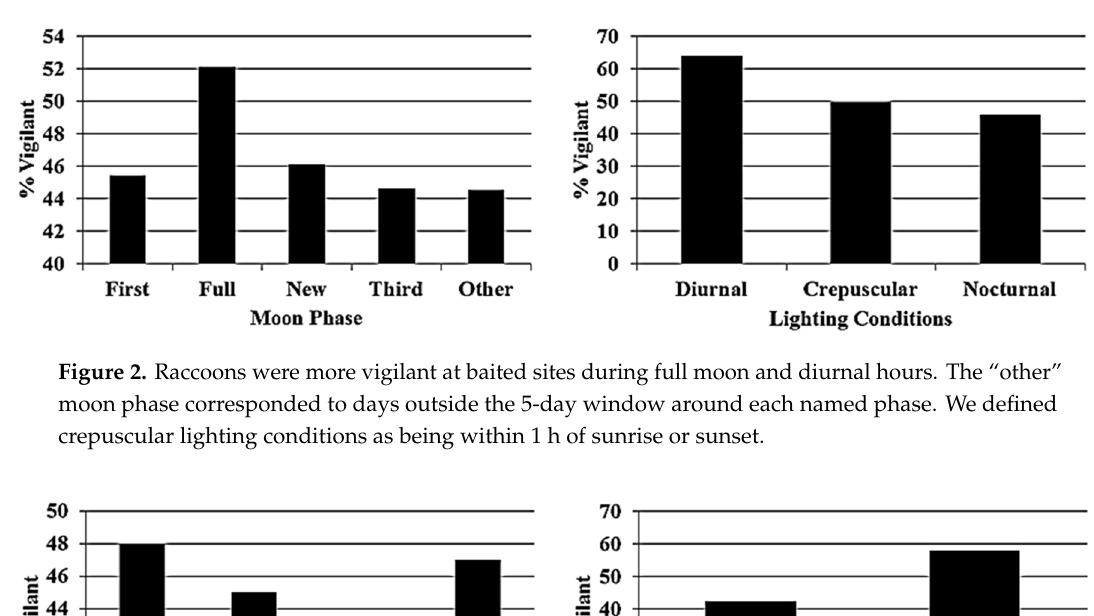
Figure 3. Raccoons were less vigilant at baited sites as group size increased and when in the presence of other species. Group sizes of 4 or more were pooled. Other species detected with raccoons included white ‐ tailed deer, coyote, southern flying squirrel, eastern cottontail, gray fox, wild turkey, and Virginia opossum.